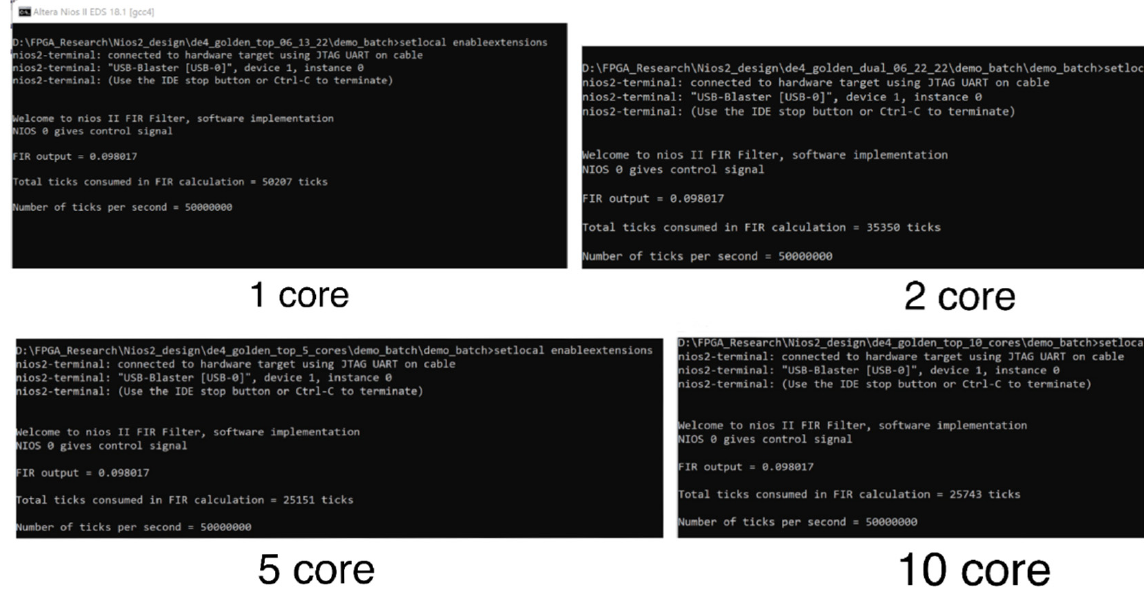
Figure 19. Screenshots for 1-, 2-, 5-, and 10-core systems from the top to the bottom.